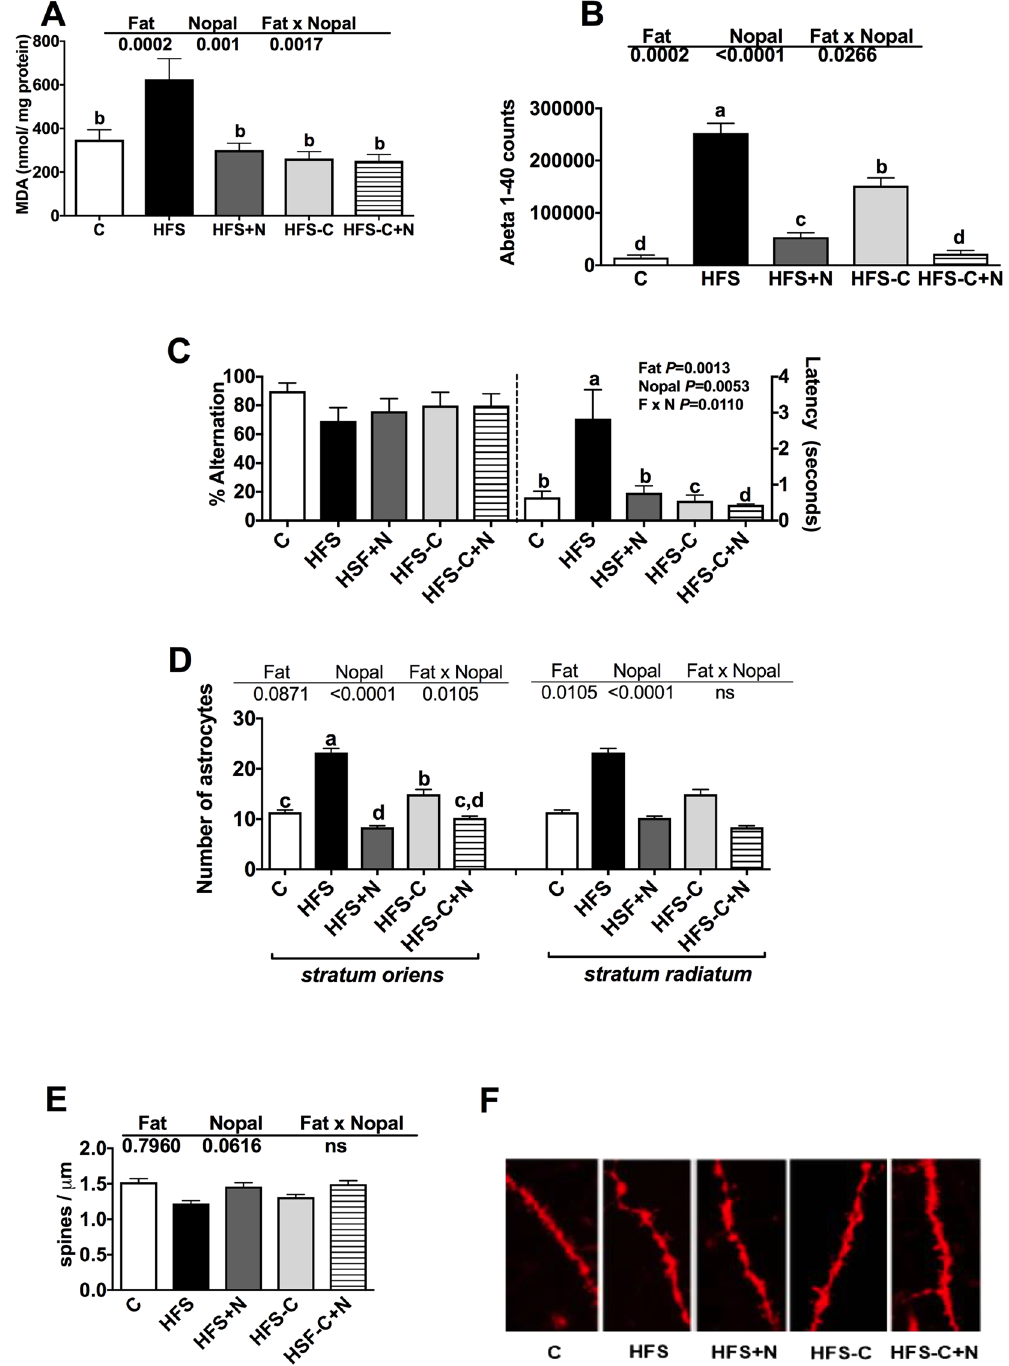
Figure 8. Nopal consumption decreases oxidative stress and improves cognitive function. ( A ) Malondialdehyde (MDA) levels in the prefrontal cortex, ( B ) abeta 1–40 peptide in the ventral CA1 region, ( C ) spontaneous alternations and latency time, ( D ) glial fibrillary acidic protein (GFAP) in the stratum oriens and the stratum radiatum , ( E ) spine density in dendrites of the CA1 region, and ( F ) morphology of dendritic spines in the CA1 region. Data are expressed as mean ± SEM (n = 5/group). Comparisons among groups were analysed by 2-way ANOVA followed by Fisher’s PLSD test. Different letters indicate significant differences among groups (a > b > c >